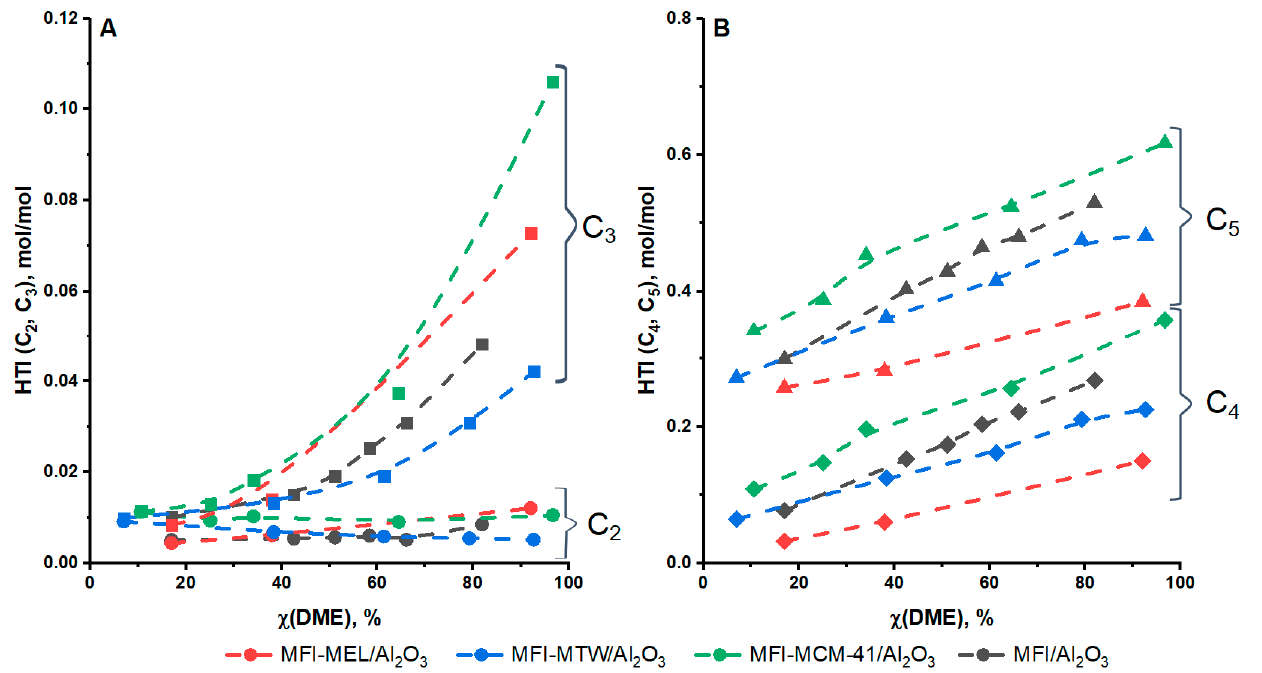
Figure 6. Hydrogen transfer index (HTI) for hydrocarbons with chain length ( A ) 2 ( ● ), 3 ( ■ ), ( B ) 4 ( ⬥ ), and 5 ( ▲ ) for MF-MEL/Al 2 O 3 , MFI-MTW/Al 2 O 3 , MFI-MCM-41/Al 2 O 3 , MFI/Al 2 O 3 catalysts, re- spectively. p = 1 atm, T = 340 °C.